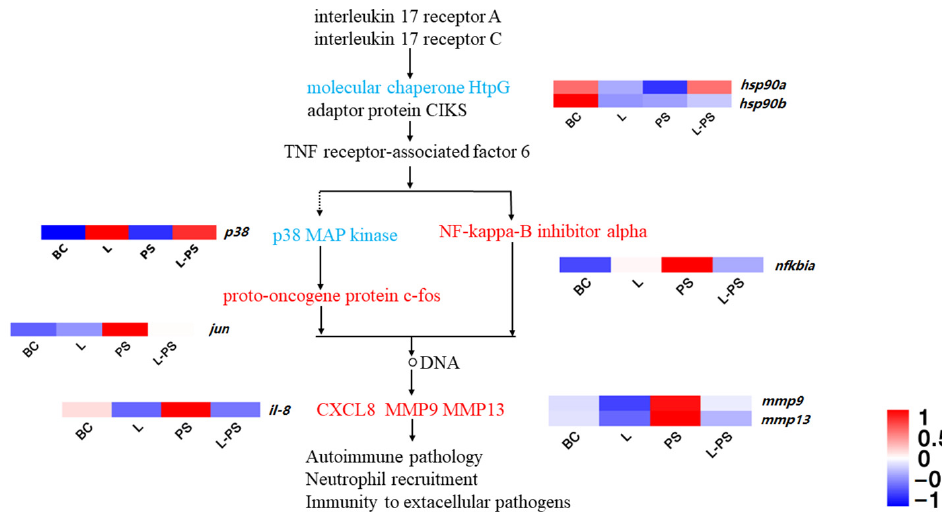
Figure 5. IL-17 signalling pathway.